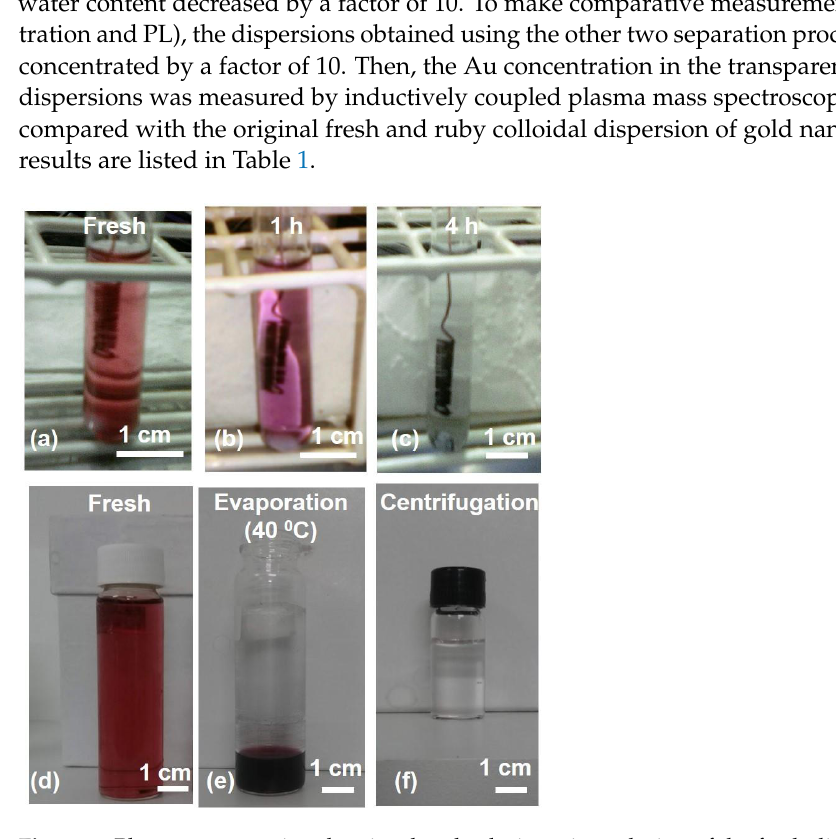
Figure 1. Photos representing the visual and colorimetric evolution of the fresh dispersion of nano- material during bleaching processes by grounding ( a , b , c ) and by evaporation followed by centrifu- gation ( d , e , f ). Table 1. Concentration of gold in the colloidal dispersion of nanomaterial before and after the different bleaching processes. The measurement was repeated on five samples, produced through independent synthesis